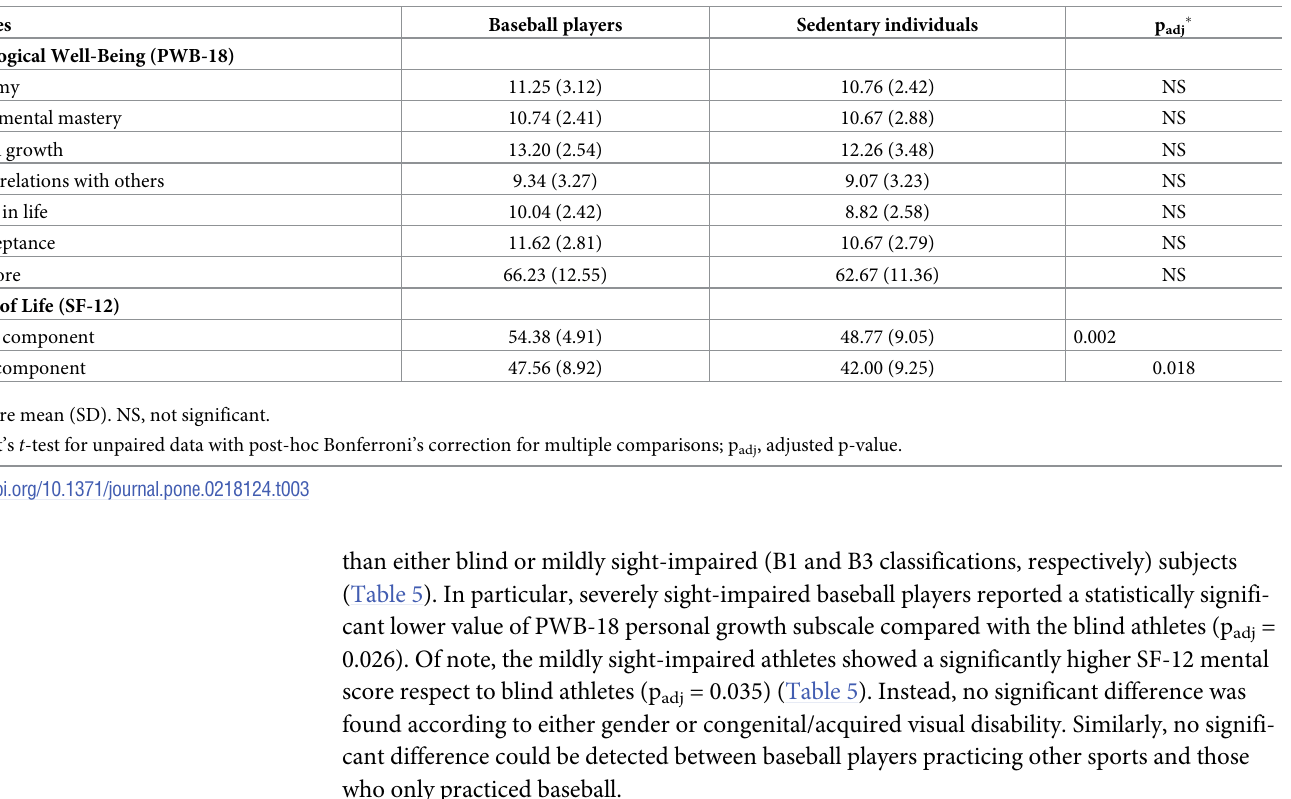
Table 3. Mean scores of psychological well-being scale and quality of life questionnaires in visually impaired baseball players compared with visually impaired sed- entary individuals. Variables